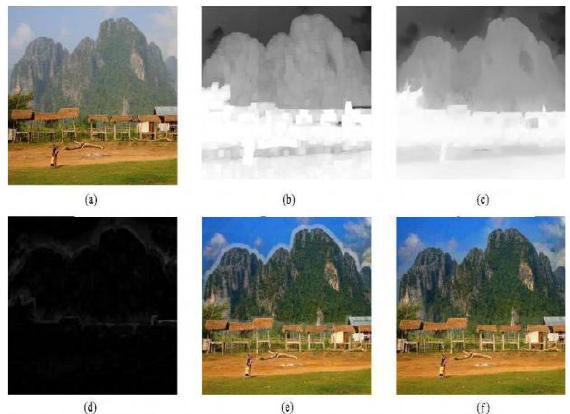
Figure 2. Dehazing photo with steep depeth variation. (a) Input image I (b)Coarse transmission map t' (c) Refined transmission map t (d) (e) Dehazing image by t (f) Dehazing image by J J 